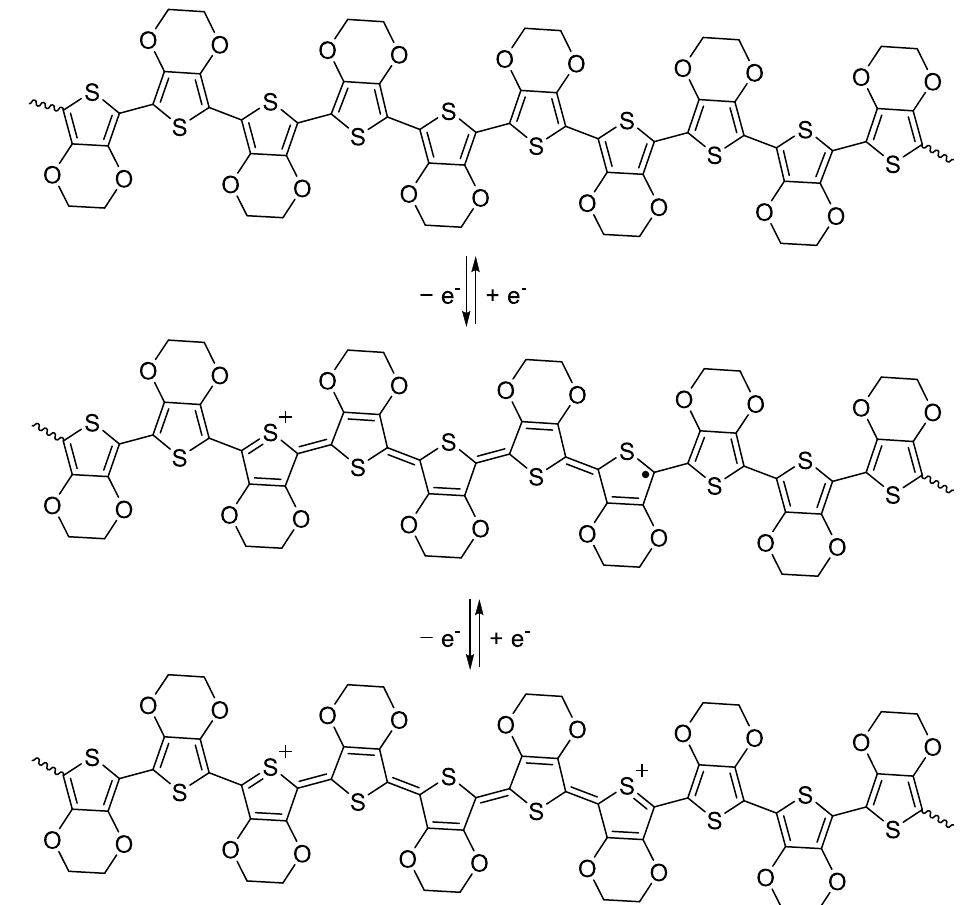
Figure 3. Reversible oxidation and reduction processes form resonance-delocalized electrons and cations (holes) along the backbone of CPs such as PEDOT. Redox processes, which are typically reversible, allow interconversion among neutral polymers ( top ), radical cations known as polarons ( middle ), and dications known as bipolarons ( bottom ). Reprinted from Ref. [45], available at https://www.mdpi.com/1996-1944/12/16/2629; accessed on 1 December 2022.